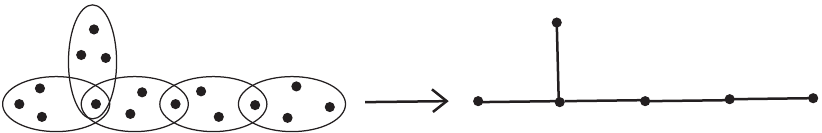
Figure 1: The 4-uniform hypertree T and the induced tree T .